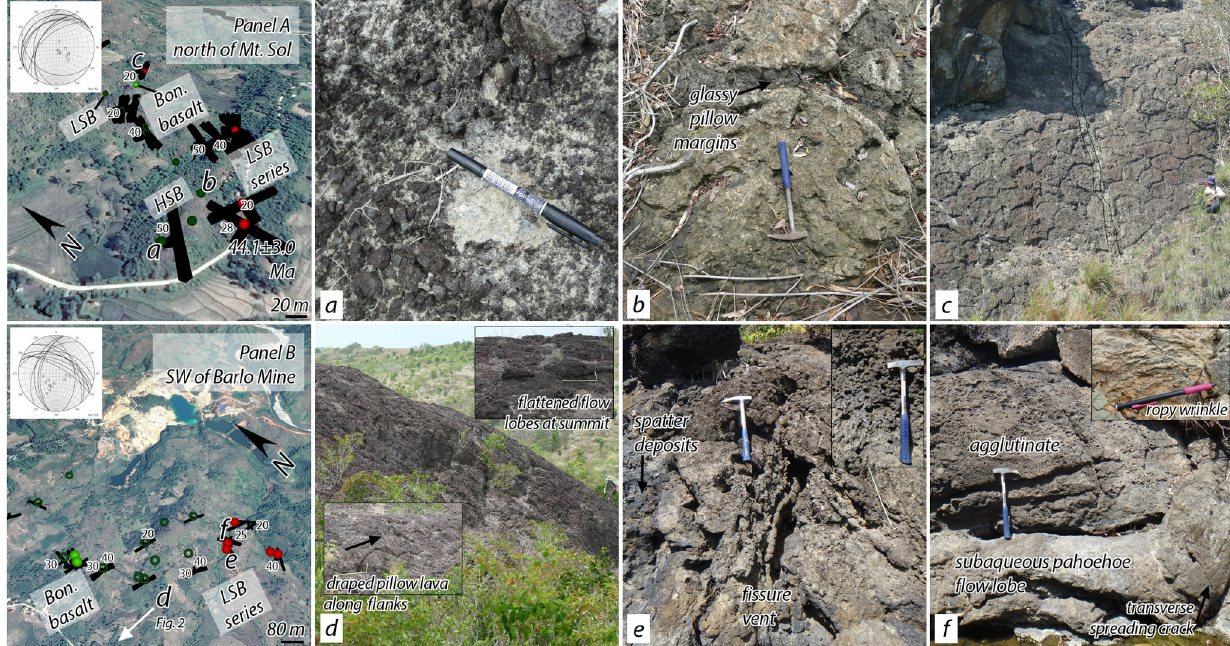
Figure 3. Representative outcrops showing distinct volcanic facies and stratigraphic relationship of the upper boninite unit and lower basaltic andesite–andesite unit. (a) High-Si boninite lapilli tuff. (b) High-Si boninite pillow lava with fresh glassy margins. (c) Basaltic andesite pillow lavas cut by boninite dike. (d) Boninite pillow volcano. (e) Fissure vent with fluidal, flattened basaltic andesite–andesite spatter deposits and lapilli tuff. (f) Basaltic andesite pahoehoe flow with ropy wrinkles (inset) and transverse spreading cracks on lobe crust indicating flow direction. Rock hammer for scale (0.42m). Orientation poles of bedding planes (dip azimuth) are shown in lower hemisphere stereographic projection (Vollmer, 2015). Bedding plane orientations in Google Earth (Digital Globe, CNES/Astrium) images, viewed from southeast direction, are visualized using the S2K macro (Blenkinsop,